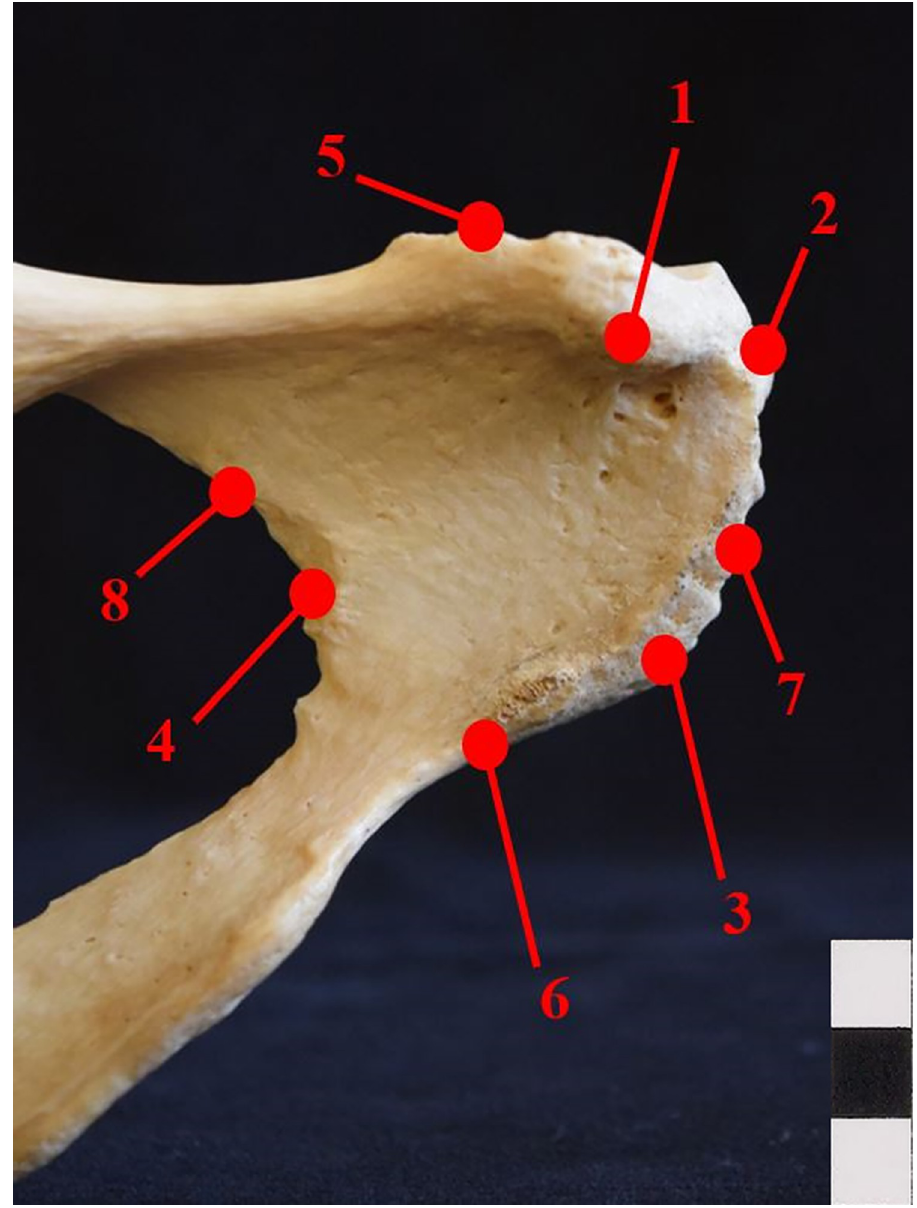
Fig 1. Location of landmarks. Anterior surface of the right pubic bone displaying approximate locations of the eight landmarks recorded on each bone; scale bar is in 1 cm blocks.